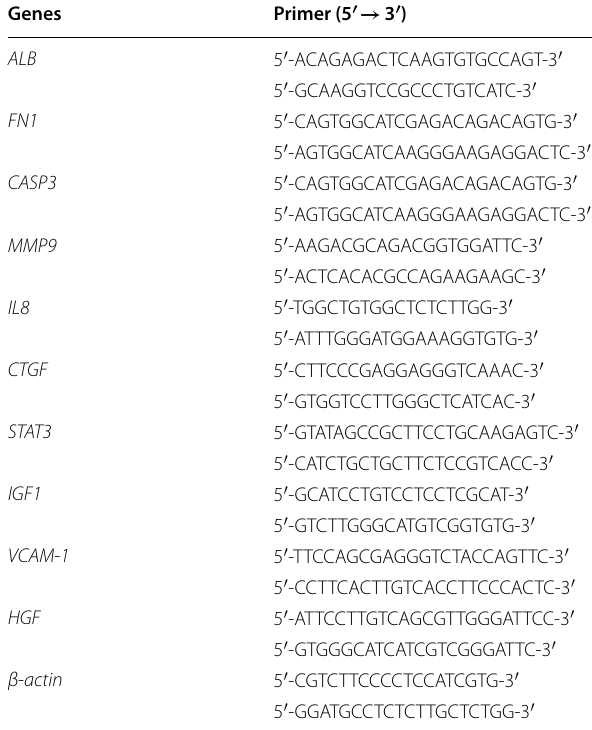
Table 1 Primer sequences used for RT-qPCR polymerase chain